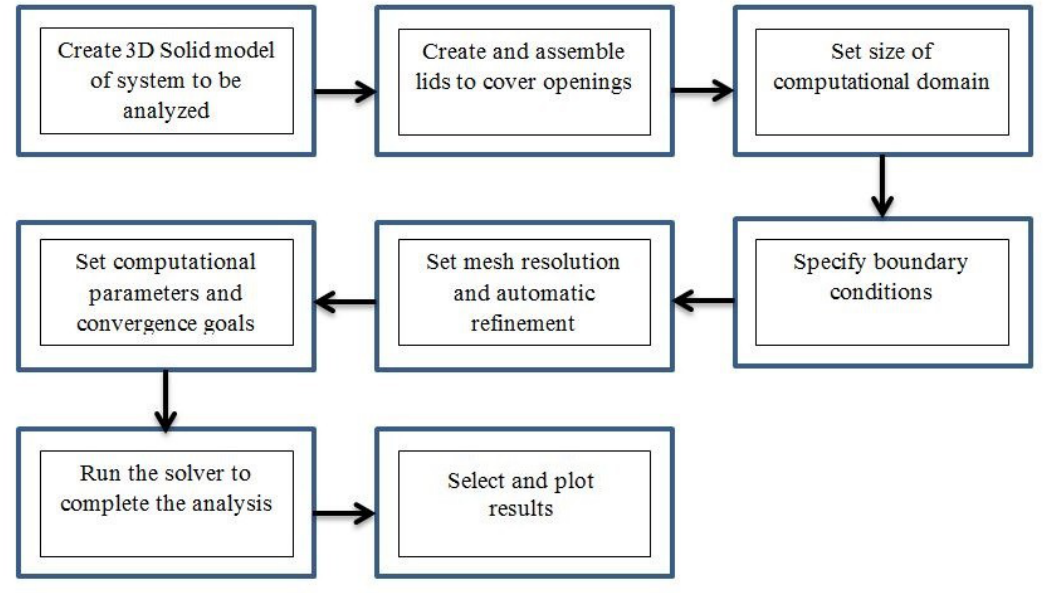
Figure 10. The primary steps in the CFD analysis